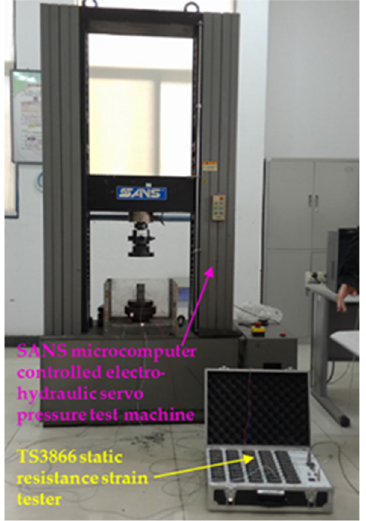
Figure 5. Instruments for measuring rock mechanical parameters.